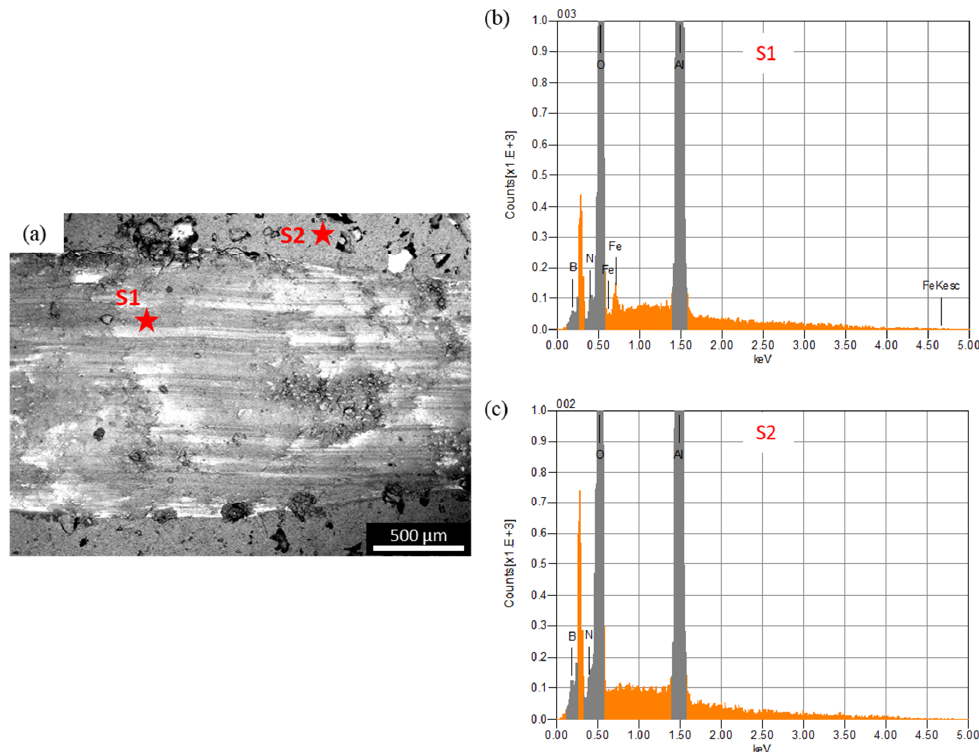
Figure 9. ( a ) SEM micrograph of the wear track on B20 composite against steel ball; ( b ) and ( c ) are the EDS spectrum at S1 and S2,